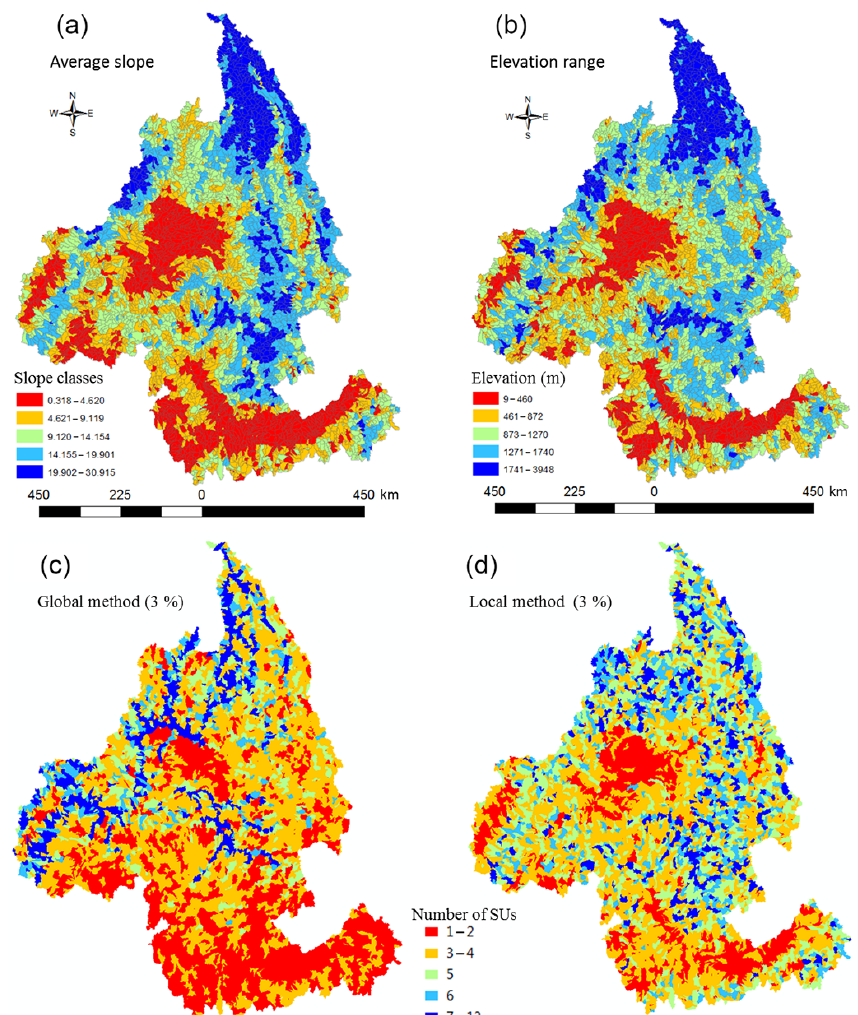
Figure 5. Spatial patterns of the number of elevation-based geo-located SUs per subbasin derived using the global (c) and local (d) methods compared to the spatial pattern of the topographic slope (a) and elevation ranges of the subbasins in the study